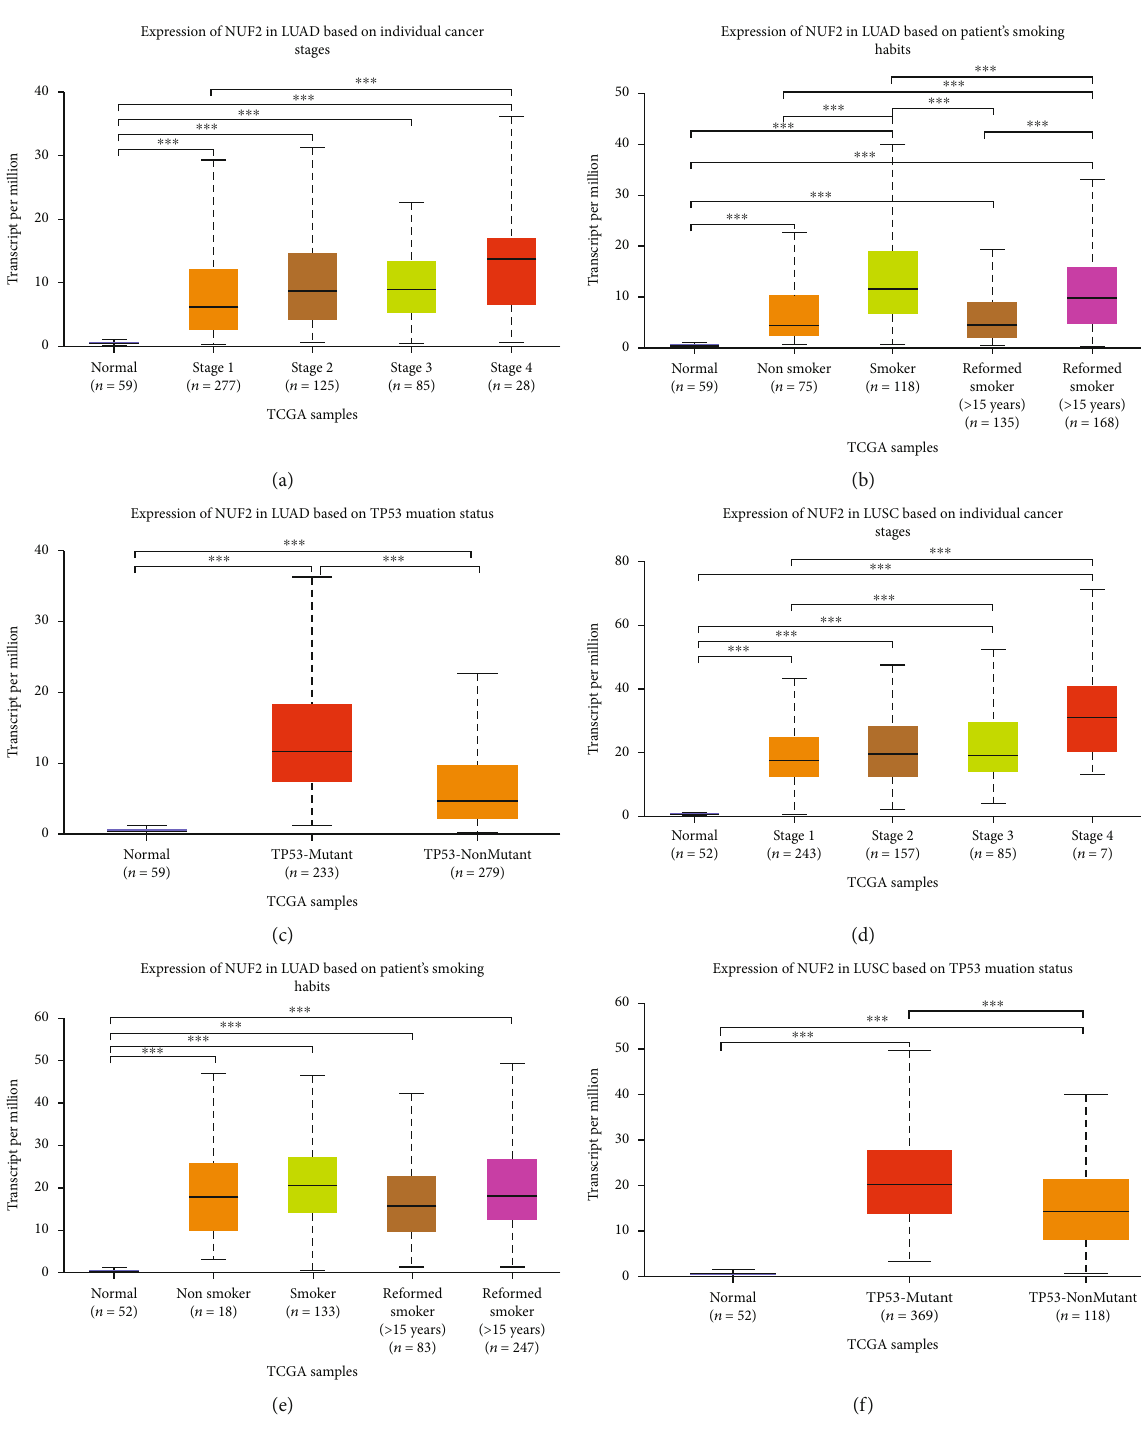
Figure 9: (a – c) Use the UALCAN website (http://ualcan.path.uab.edu/cgi-bin/ualcan-res.pl), respectively, to show the expression di ff erences of NUF2 lung adenocarcinoma tumors in di ff erent grades, normal population, and lung adenocarcinoma. The expression of NUF2 in di ff erent smokers and the di ff erence in the expression of NUF2 in TP53 mutant and nonmutated lung adenocarcinoma. (d – f) The di ff erences in the expression of NUF2 lung squamous cell carcinoma tumors of di ff erent grades, the expression of NUF2 in normal people and di ff erent smokers of lung squamous cell carcinoma, and the di ff erence in expression of NUF2 in TP53 mutated and nonmutated lung squamous cell carcinoma. ∗∗∗∗ P < 0 : 001 indicates that the di ff erence is statistically signi fi